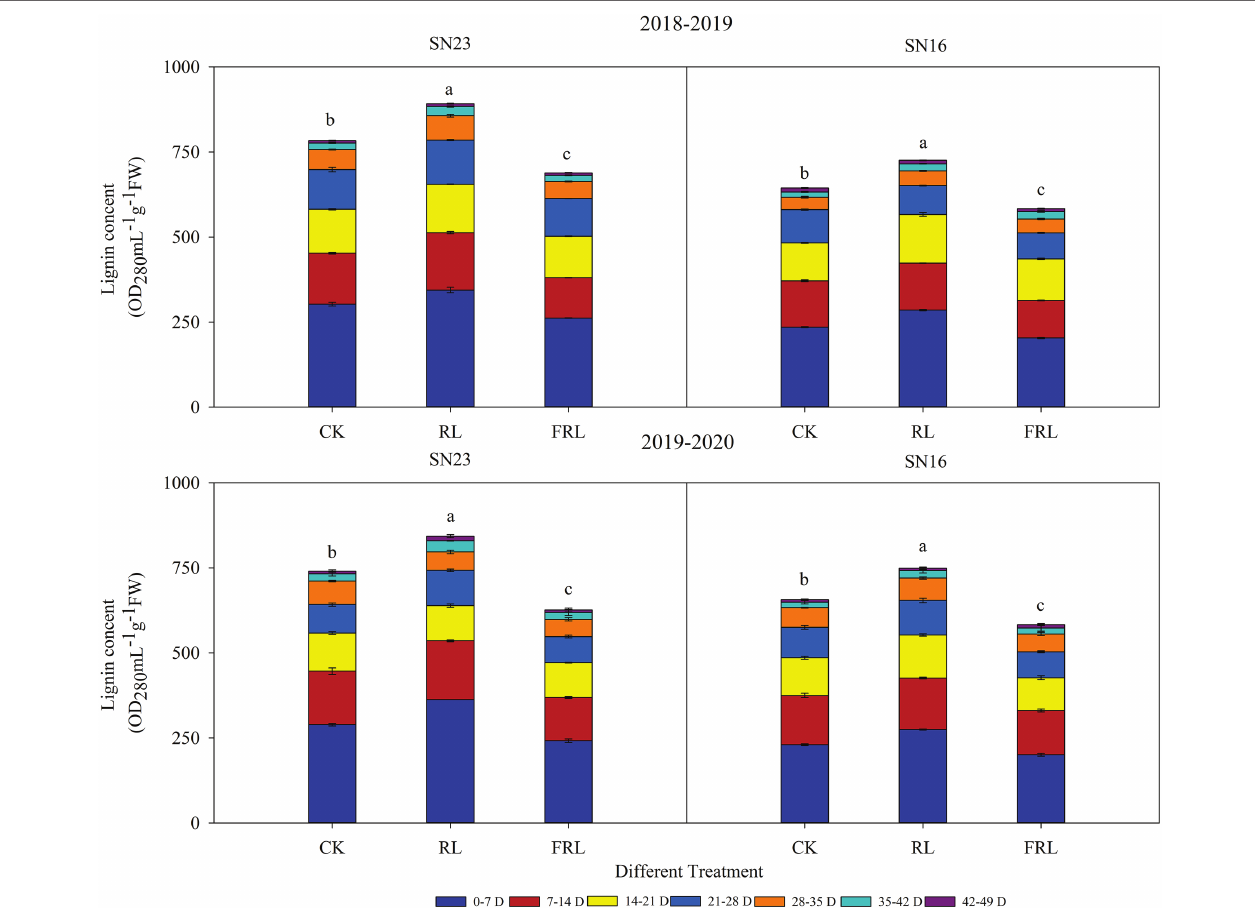
FIGURE 4 | The effect of light quality in population on lignin accumulation in wheat in 2018–2019 and 2019–2020 growing seasons, respectively. SN16 and SN23 represent the lodging-sensitive cultivar Shangnong16 and the lodging-resistant cultivar Shangnong23. CK represents the normal light, RL represents the red light, and FRL represents far-red light. Different colors represent the days after the second internode formation in the 2018–2019 and 2019–2020 growing seasons. FW, fresh weight. Vertical bars above mean values indicate SDs ( n = 3). Means show significant differences between treatments according to the LSD ( p <